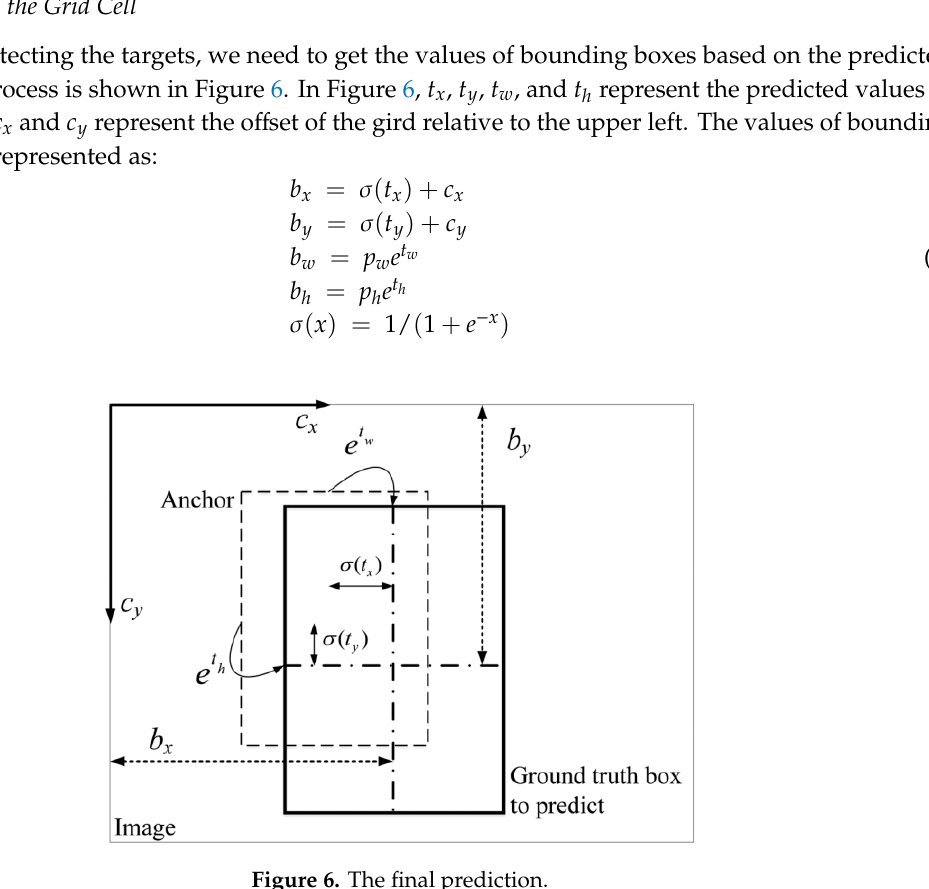
Algorithm 2: The pseudocode of non-maximum suppression (NMS) for our approach Original Bounding Boxes ：